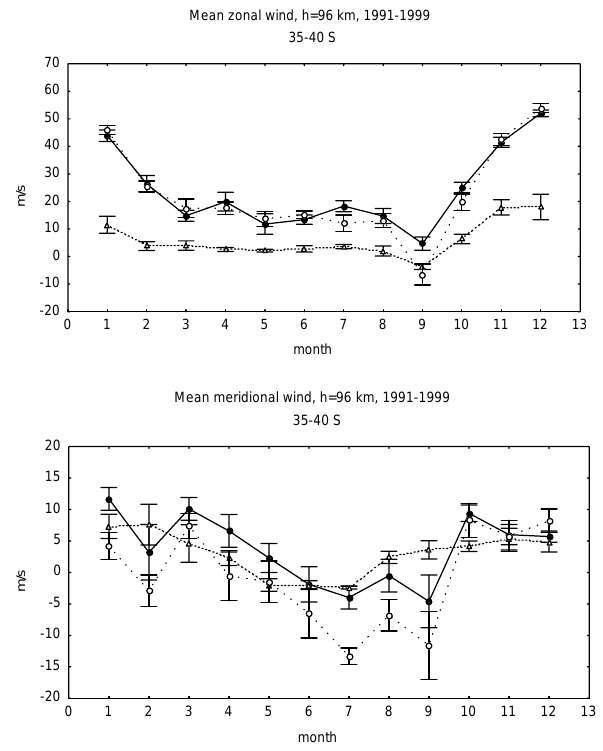
Fig. 7. Climatic season variations of the prevailing zonal (top) and meridional (bottom) wind components at 96km during 1991–1999 as seen by HRDI and by the MF at Adelaide. Filled circles: HRDI data for the 35 ◦ –40 ◦ S latitude belt, averaged over all longitudes. Open circles: HRDI data for the 93 ◦ –183 ◦ E longitude sector. Open triangles: Adelaide data (35 ◦ S, 138 ◦ E). Vertical bars represent one standard deviation.